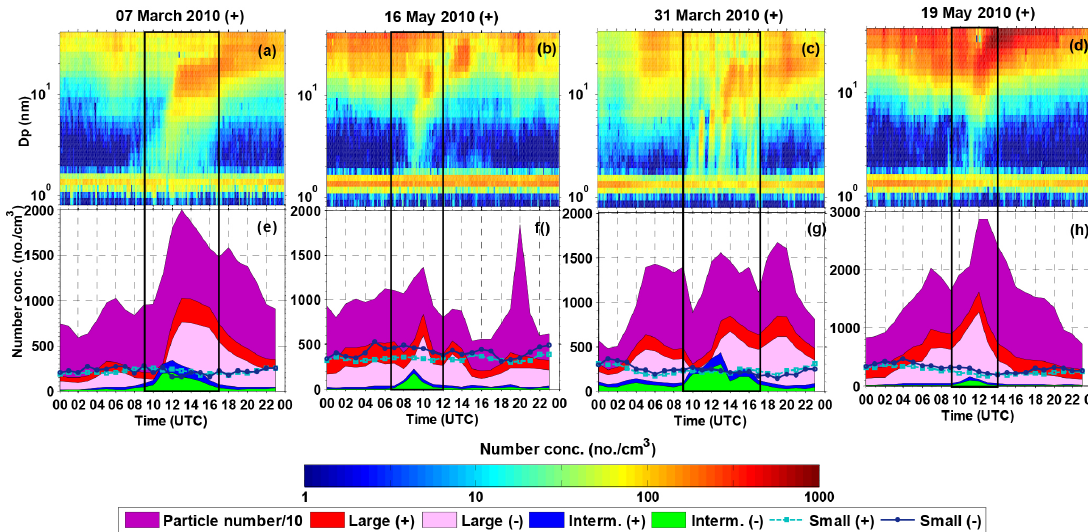
Figure 6. Examples of NPF event days observed in the LHVP site. The first row of figures represent positive ions measured using AIS (dp: 0.8–42nm) with a time resolution of 3min. The second row represents mean number concentrations of particle total number ( > 6nm), small (0.8–2nm), intermediate (2–7nm), and large ions (7–20nm), at a resolution of 1h. Note that absolute particle number concentration is obtained by multiplying the concentrations by 10. The black rectangles indicate the NPF